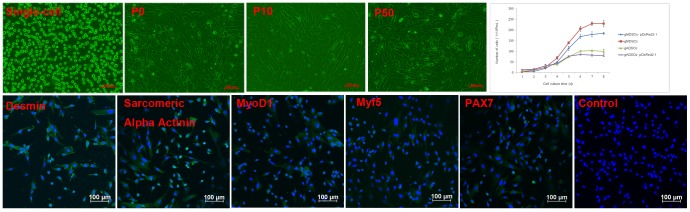
Morphologic changes, identification and growth of gMDSCs.Cell suspensions from skeletal muscle tissues were found to contain large numbers of small and rounded satellite cells. The vast majority of cells first transformed into spindle-shaped mononuclear cells after the second passage. Positive desmin, α-sarcomeric actinin, MyoD1, Myf5, and PAX7 immunostaining was visualized as green, whereas DAPI-positive nuclei were stained blue. gMDSCs and gMDSCs–pDsRed2-1 entered an exponential growth phase between days 2 and 3, and reached a growth plateau between days 6 and 7. gADSCs and gADSCs–pDsRed2-1 gave results similar to those for gMDSCs and gMDSCs–pDsRed2-1. gMDSCs, goat muscle-derived satellite cells; gADSCs, goat adipose-derived mesenchymal stem cells.